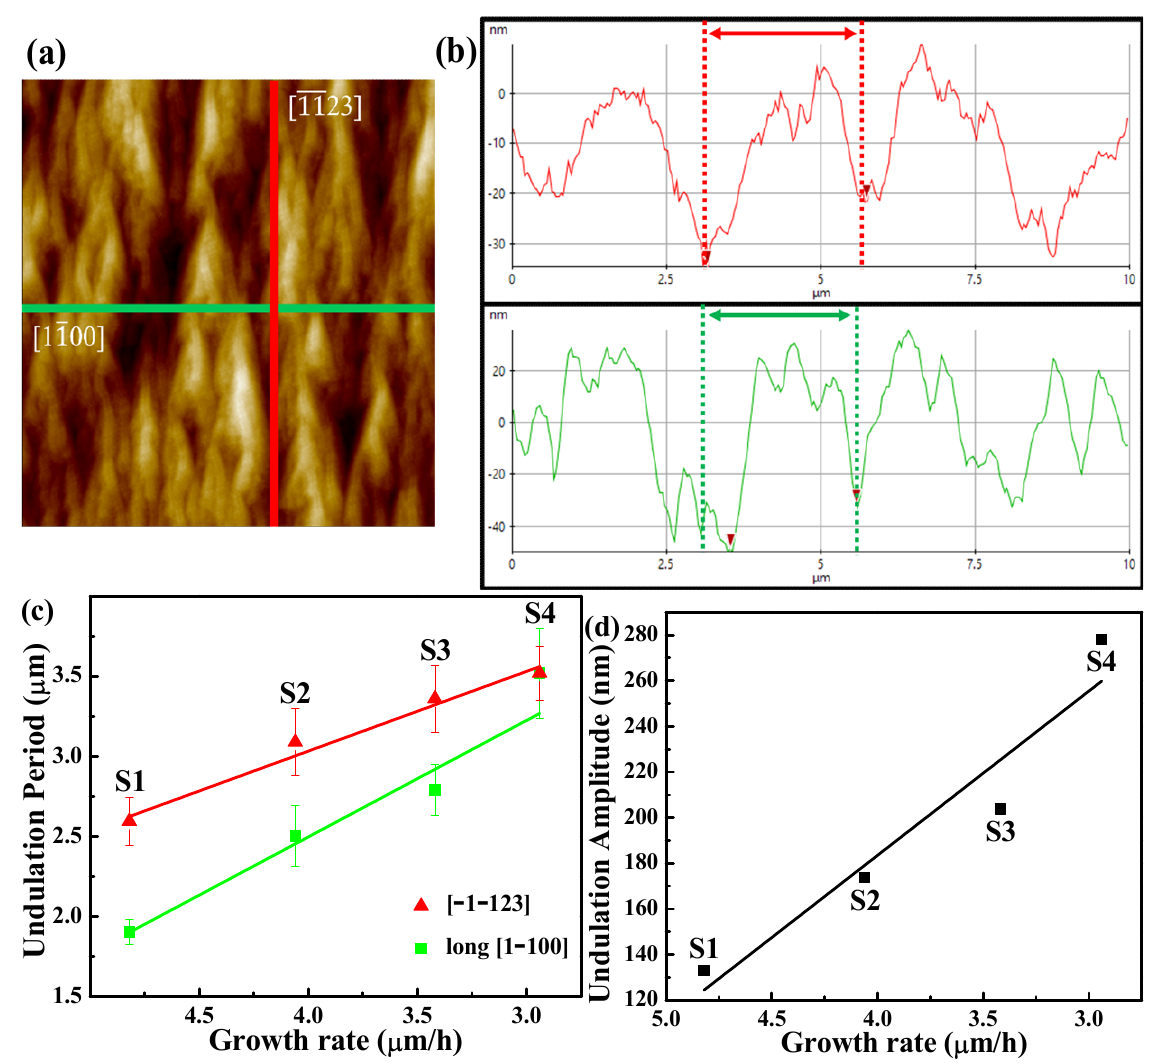
Figure 6. ( a ) Line profiles extracted from AFM micrograph along [1123] (red) and [11 00] (green) directions. ( b ) Examples of line profiles extracted along [11 23] (red) and [11 00] (green) directions with their respective undulation period. ( c ) Undulation period length of semi-polar GaN in [11 23] and long [11 00] as a function of growth rate. ( d ) Undulation amplitude of all samples as a function of growth rate. Table 2. Ratio of undulation period across [11 23] to [11 00] and RMS roughness of each sample. Sample S1 S2 S3 S4 Ratio of undulation period across